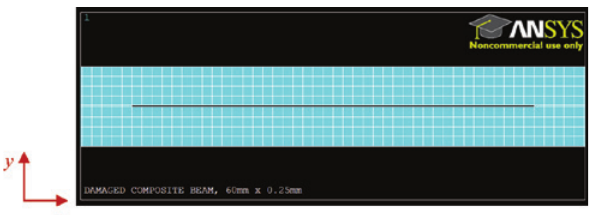
Figure 6: Typical damaged composite